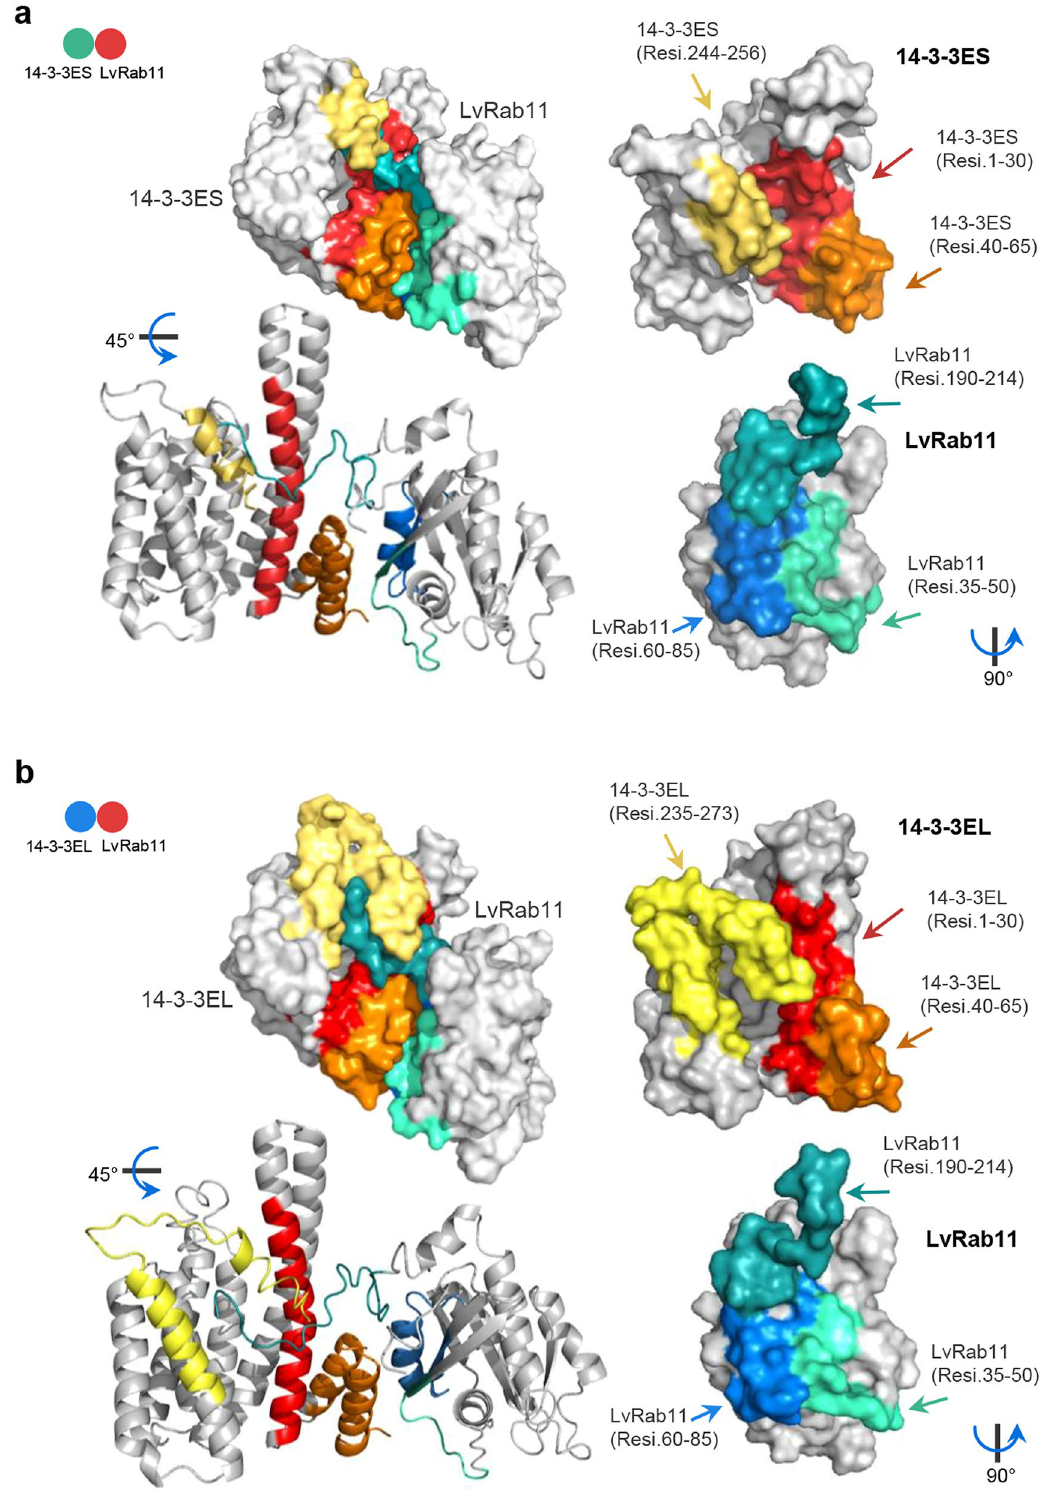
Figure 3. Docking simulation of 14-3-3 isoforms and the LvRab11 Interaction complex. 14-3-3 and LvRab11 were docked using the default parameters of the ClusPro 2.0 server 19,20 and AutoDock software 21,22 . The first ranking of the simulated complex was selected to explore the binding sites in detail. ( a ) We assigned a 3D model of 14-3-3ES (coloured turquoise) as a receptor and LvRab11 (cherry-red) as a ligand for protein interaction complex simulation. ( b ) Interaction complex of 14-3-3EL:LvRab11, where 14-3-3EL is coloured blue-marine and LvRab11 is coloured cherry-red. The interaction structures of 14-3-3ε and LvRab11 were generated using PyMOL molecular graphic version 2.4.1 (https:// pymol.